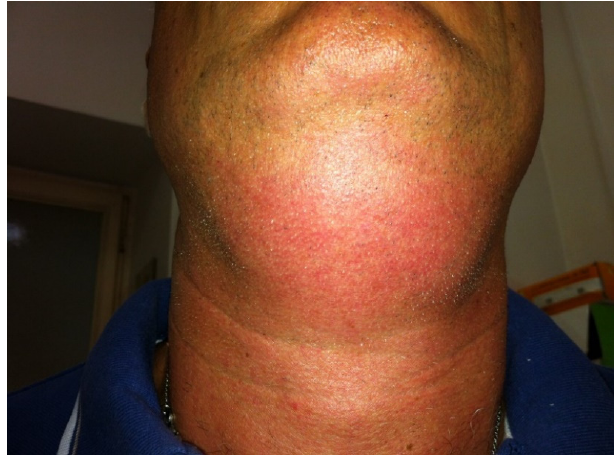
Figure 7. A huge degree of swelling, redness and bruising after DCA injections.